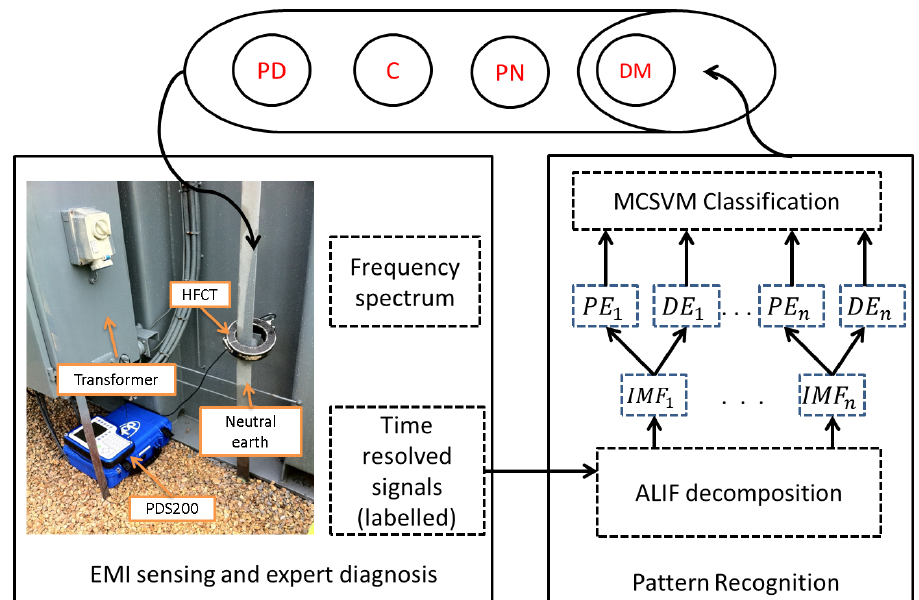
Figure 1. Overall process diagram of the proposed approach from data acquisition to pattern recognition of Electro-Magnetic Interference (EMI) events: Partial Discharge (PD), Corona (C), Process Noise (PN) and Data Modulation